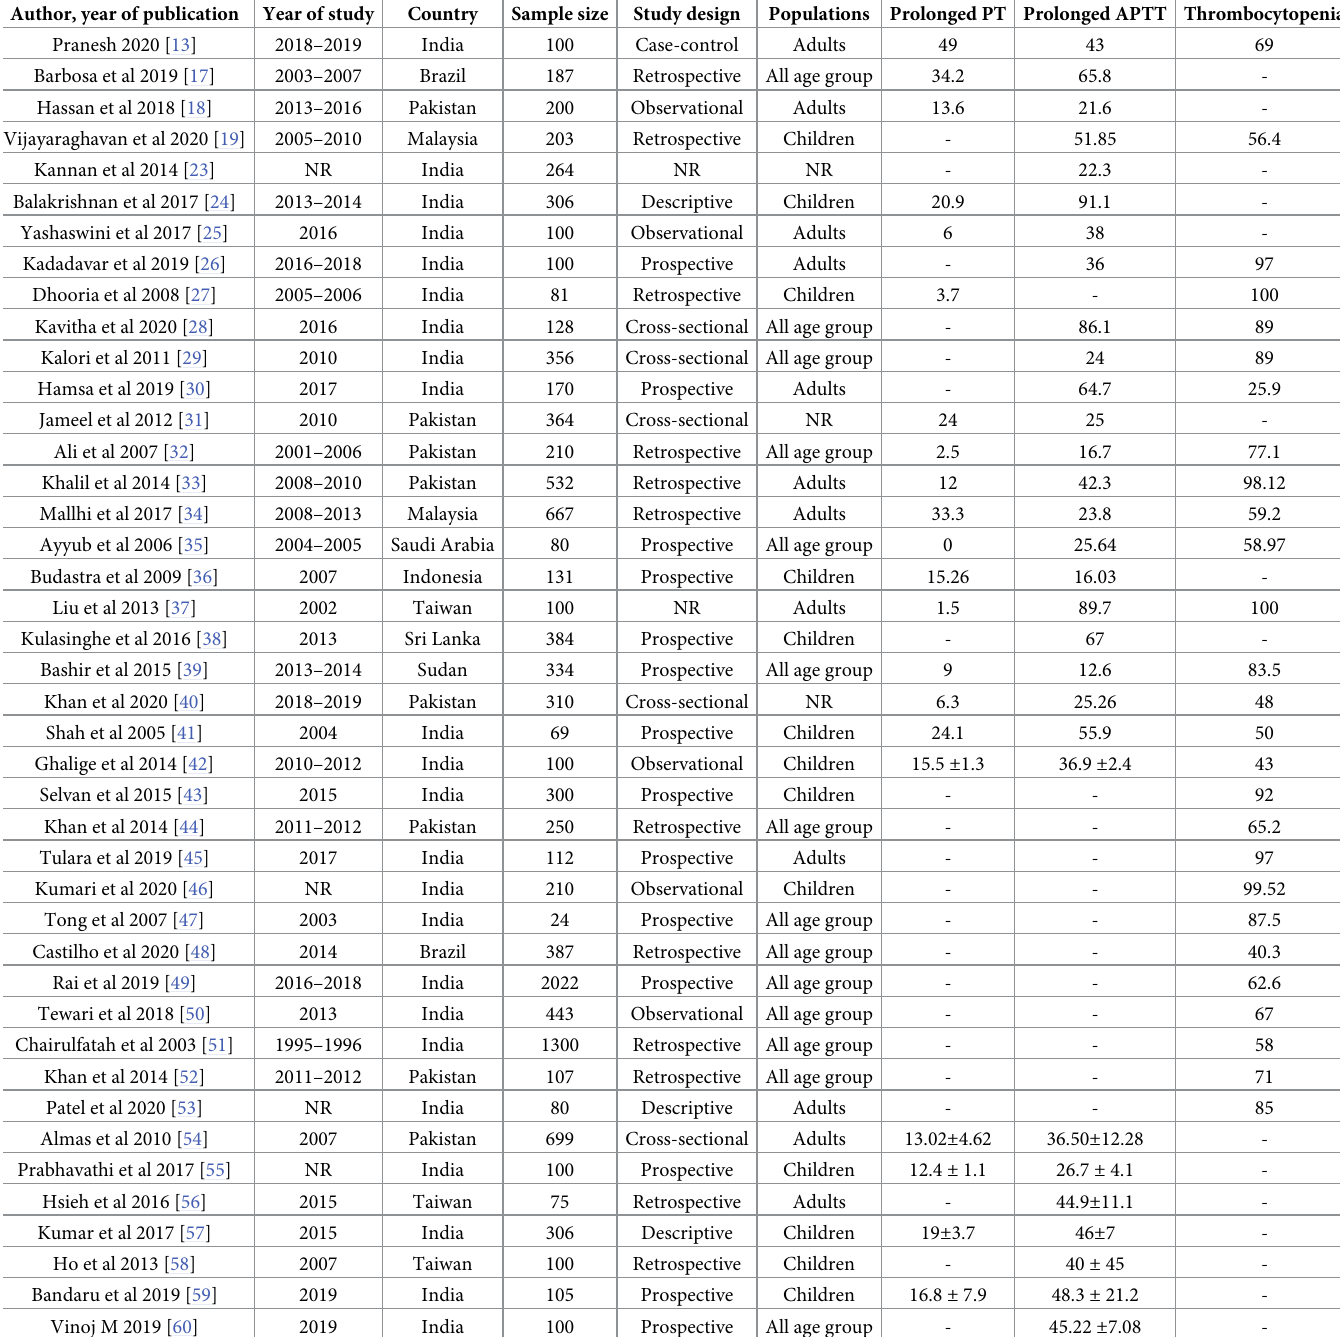
Table 1. Characteristics of included